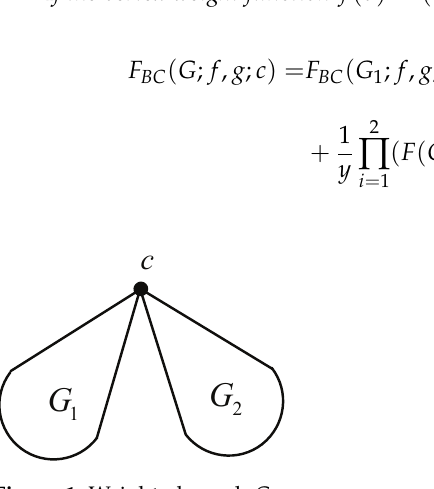
Figure 1. Weighted graph G